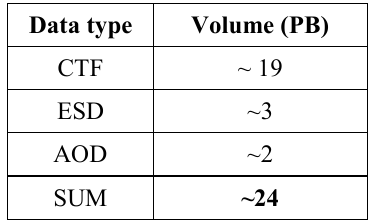
Table 4. The total amount of data created during the 1st year of Run